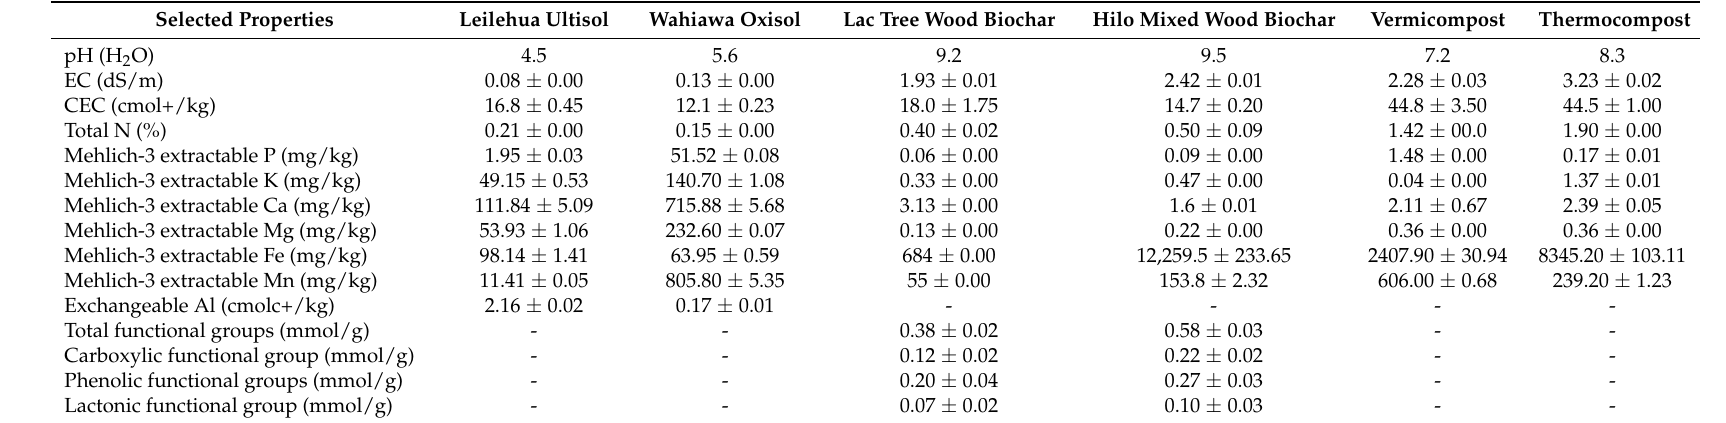
Table 1. Selected chemical properties of the soils, biochars and composts used in the experiment. Selected